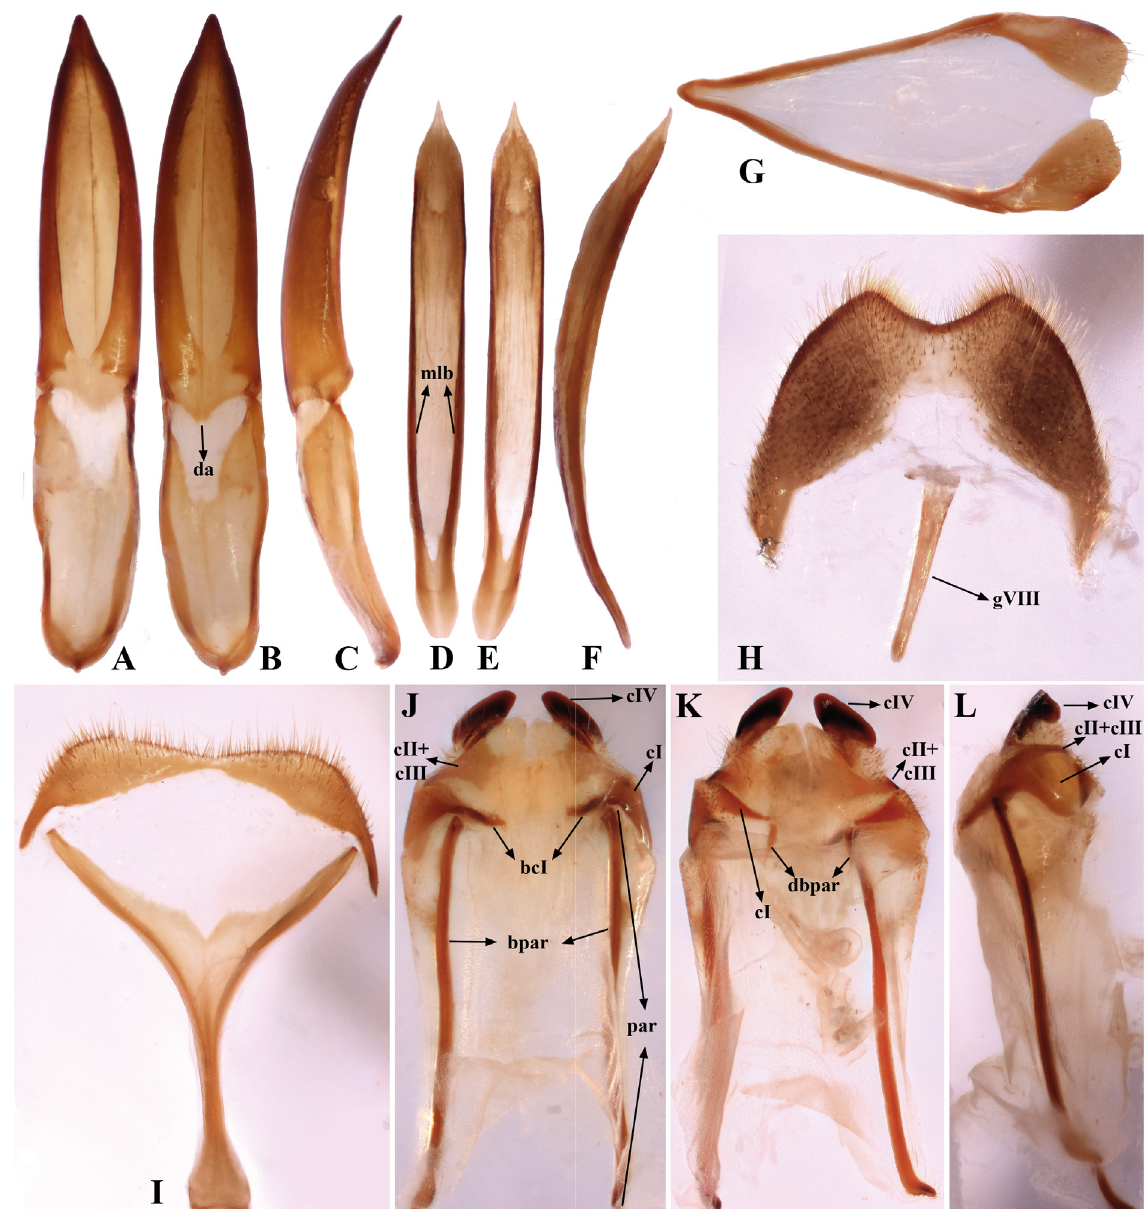
Fig. 22. Earophanta serrata (Semenov, 1893) , genitalia (ZIN). A . Tegmen of aedeagus, ventrally. B . Ditto, dorsally. C . Ditto, laterally. D . Median lobe, ventrally. E . Ditto, dorsally. F . Ditto, laterally. G . Spiculum gastrale. H . ♂, inner sternite VIII. I . ♀, inner sternite VIII and spiculum ventrale. J . ♀, ovipositor, ventrally. K . Ditto, dorsally. L . Ditto, laterally. Not to scale. Abbreviations: see Material and